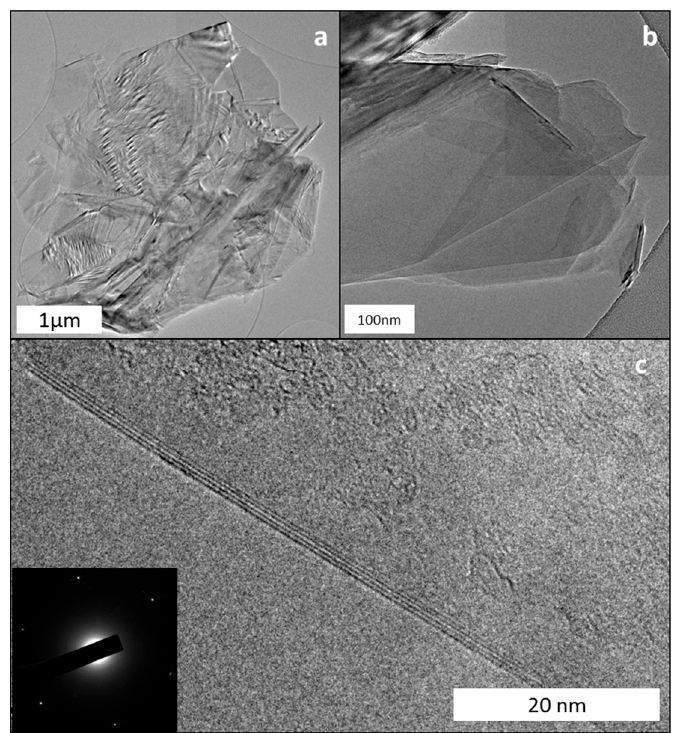
Figure 22. TEM observations performed on thin BNNSs: ( a ) Representive TEM image obtained on a 5–10 µm size BNNS; ( b ) TEM image showing BNNSs delamination; ( c ) HRTEM image obtained on a 4- layers BNNS (inset: corresponding SAED).